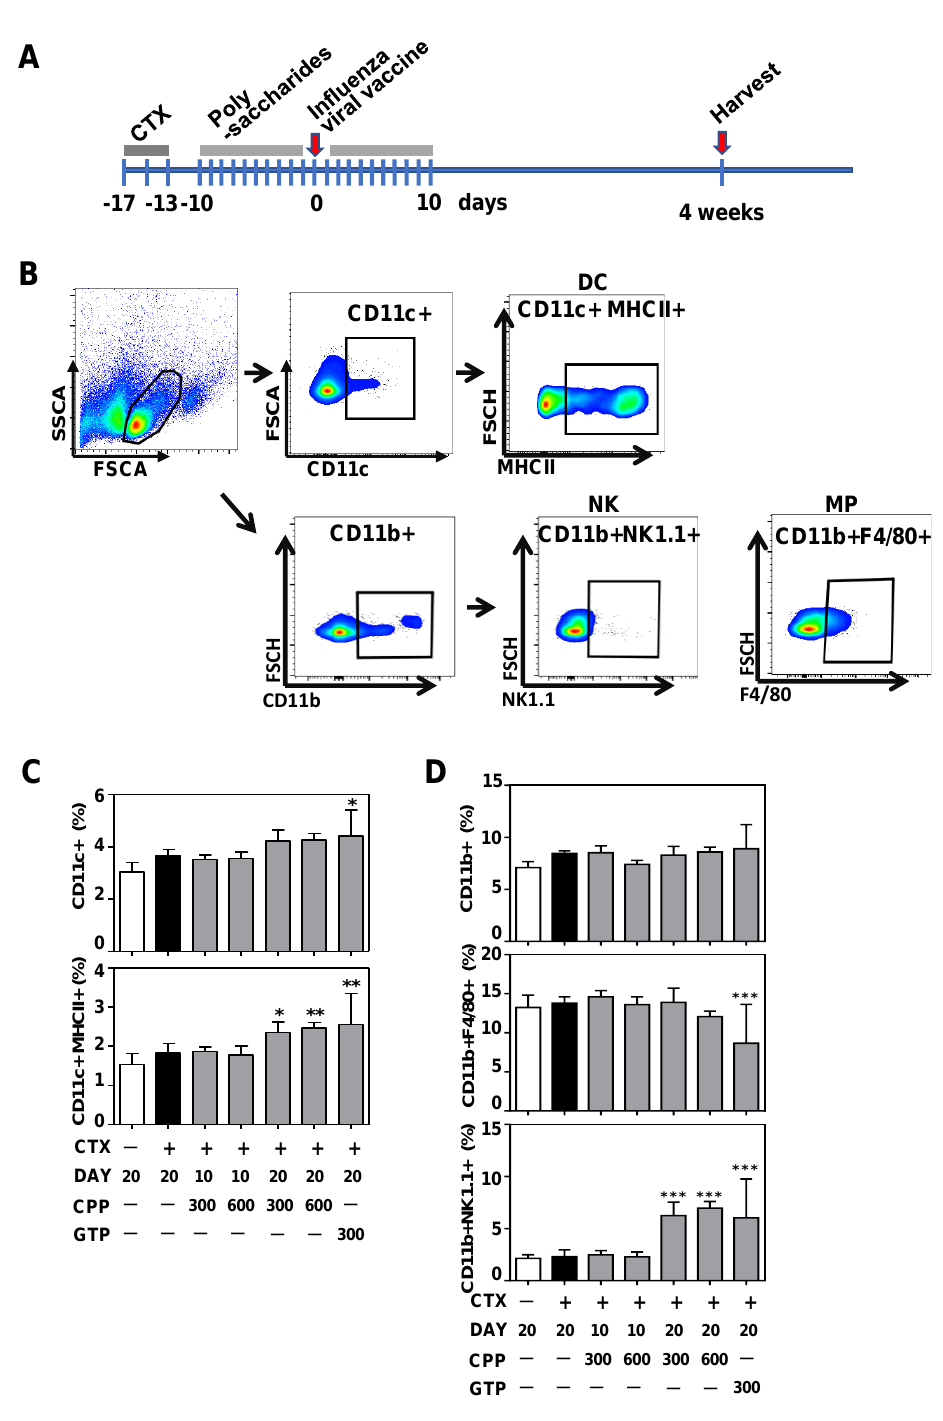
Figure 2. CPP increased the frequency of DCs and NK cells in the splenocytes of vaccinated mice. ( A ) Schematic diagram of the animal experiments. Mice were injected intraperitoneally (IP) with cyclophosphoamide (CTX) and administered an inactivated influenza vaccine. Polysaccharide solutions or vehicle were orally administered either 10 d before vaccination or 10 d both before and after vaccination ( n = 8). ( B ) Flow cytometry scheme for quantifying dendritic cells (DCs), natural and macrophages (MP) in splenocytes isolated from the mice. Frequency of ( C ) DC-enriched (CD11c + and CD11c + MHCII + ) and ( D ) CD11b + or NK cell-enriched (CD11b + NK1.1 + ) populations isolated from mice treated at the indicated dose and duration. n = 8. Normal distributions of the data were confirmed using GraphPad Prism. Statistical di ff erence to the CTX only control (black bar) by one-way ANOVA with Tukey’s post hoc test. * p < 0.05, ** p < 0.01, *** p <